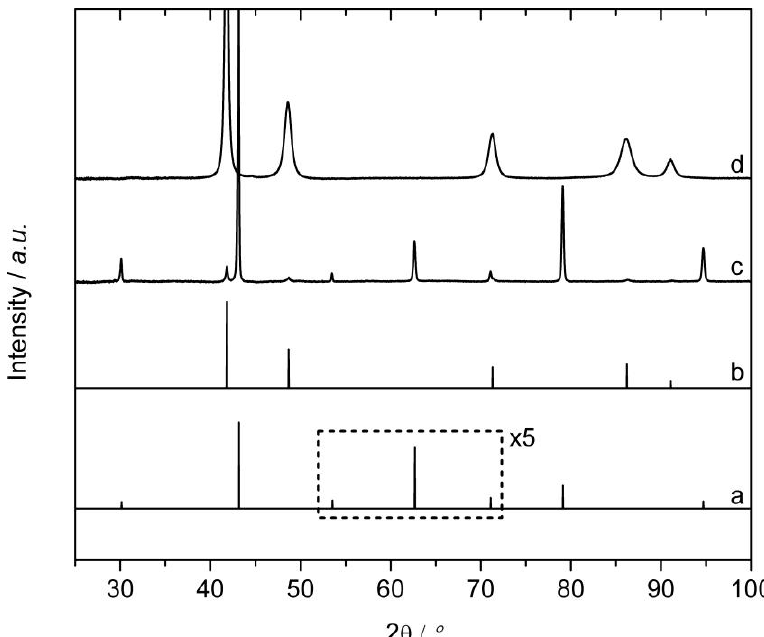
Pd ( a = 2.9624 Å); 60 40 Pd 60 40 Pd (annealed at 800 60 40